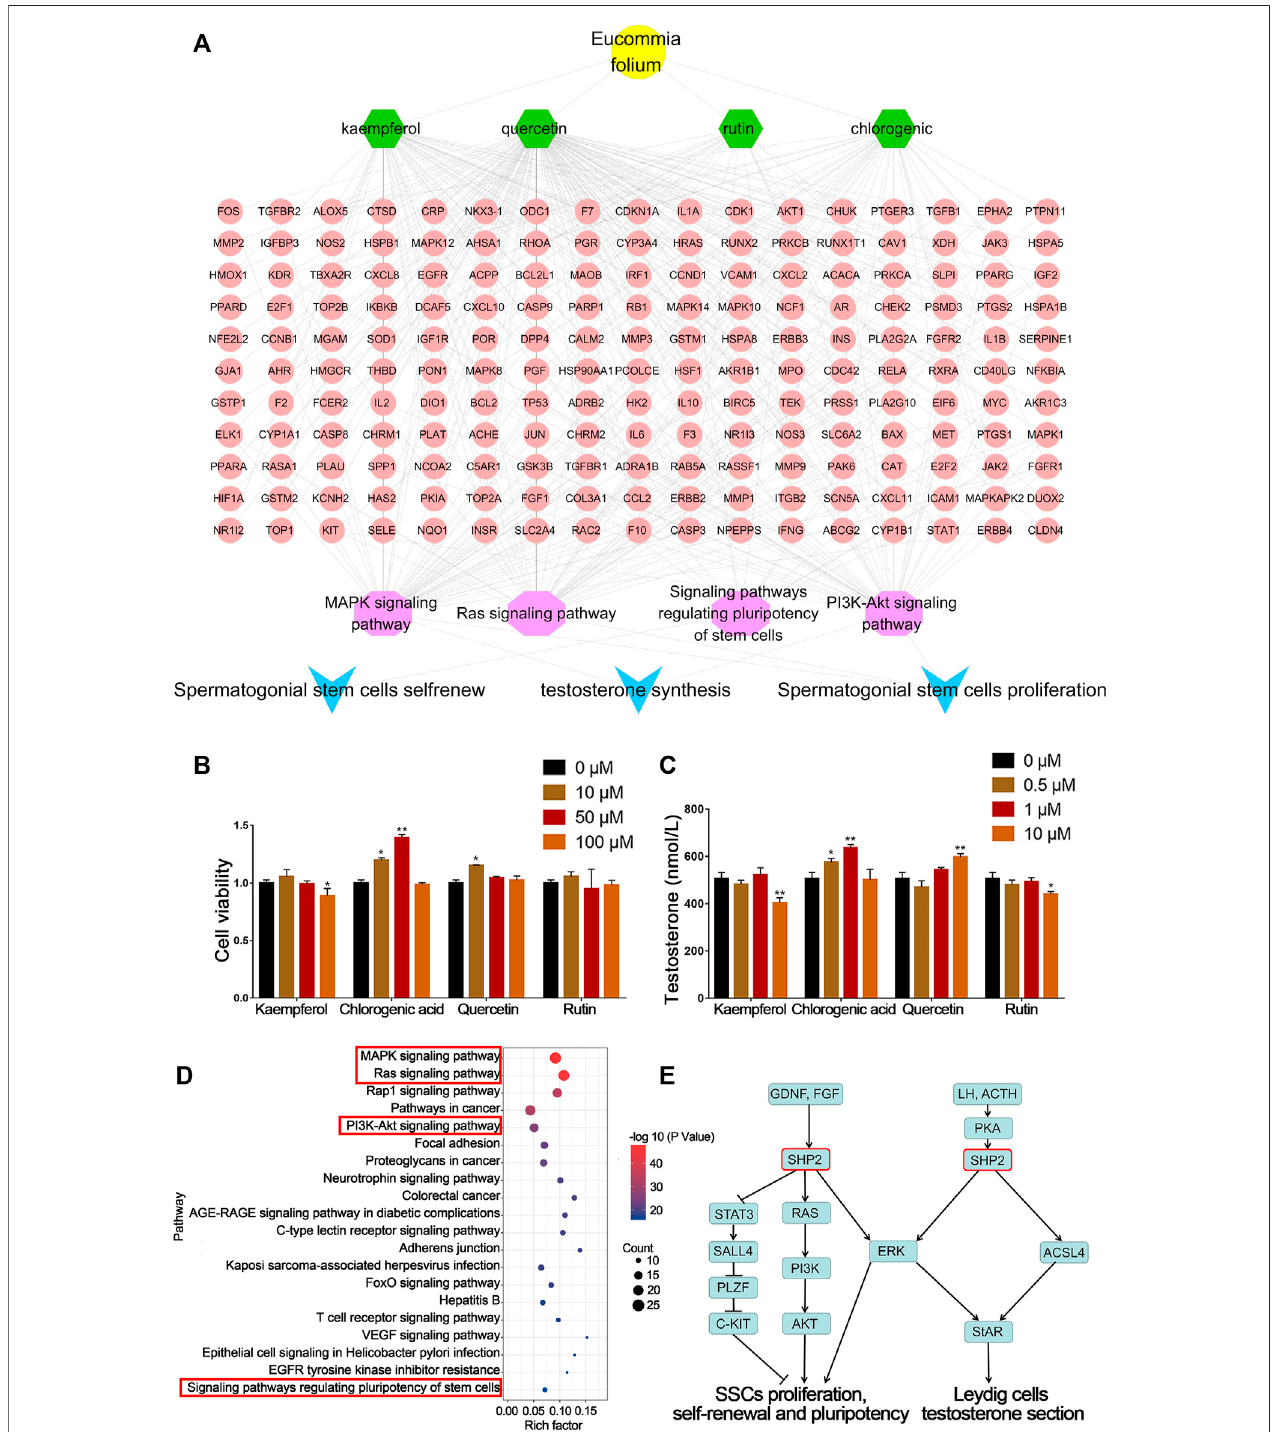
FIGURE 2 | Network pharmacology prediction and validation of spermatogenesis related compounds in EF. (A) Network pharmacology analysis of EF active compoundsandtheirmechanism. (B) C18-4cellviability. (C) TestosteronesecretioninTM3cells. (D , E) KEGGpathwayanalysisofputativetargetgenesofCGA.Values are expressed as the mean ± SD ( n = 3). * p < 0.05, ** p < 0.01 vs 0 μ M.